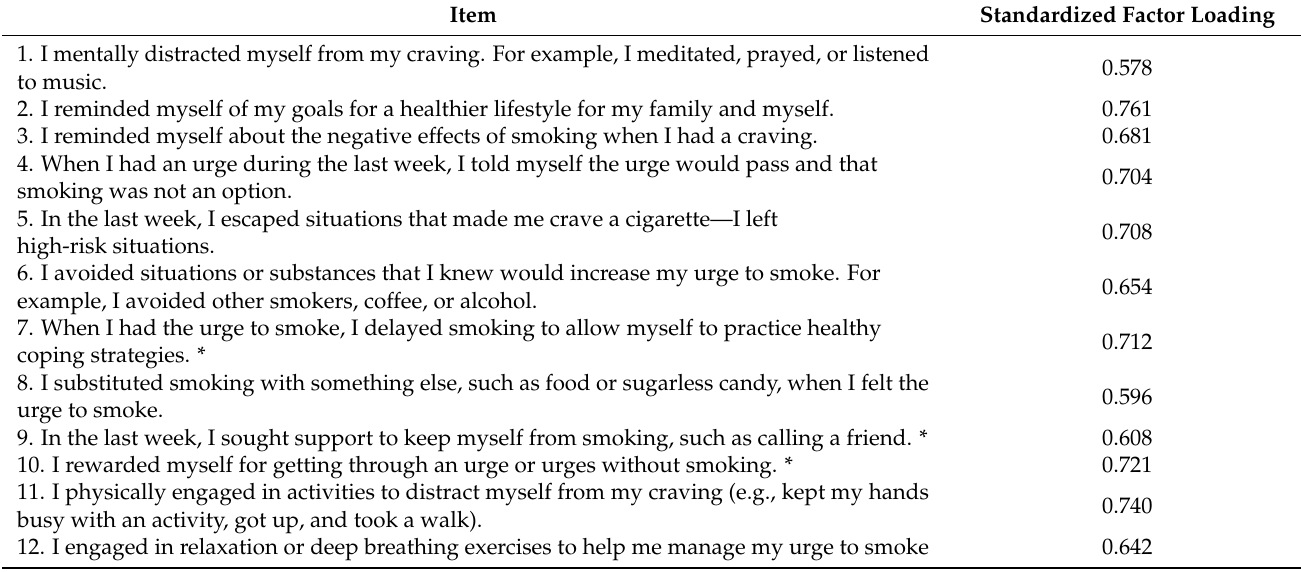
Table 1. Tobacco Urge Management Scale (TUMS) items and factor